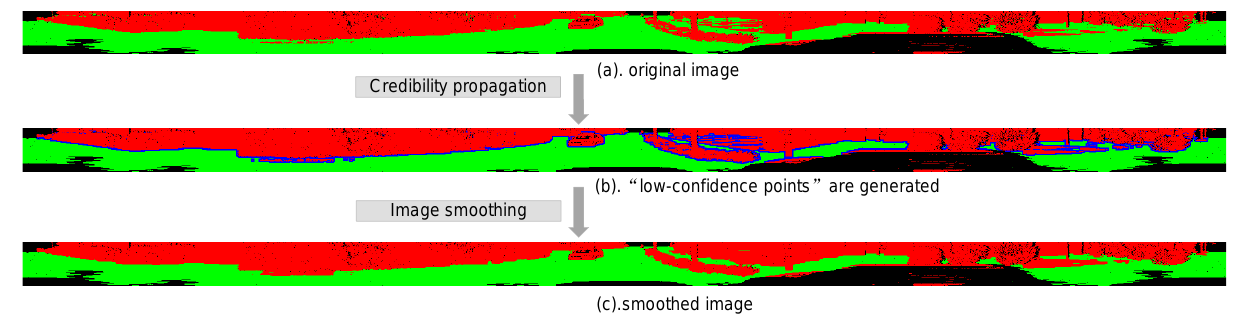
Figure 5. Fine segmentation based on jump convolution process